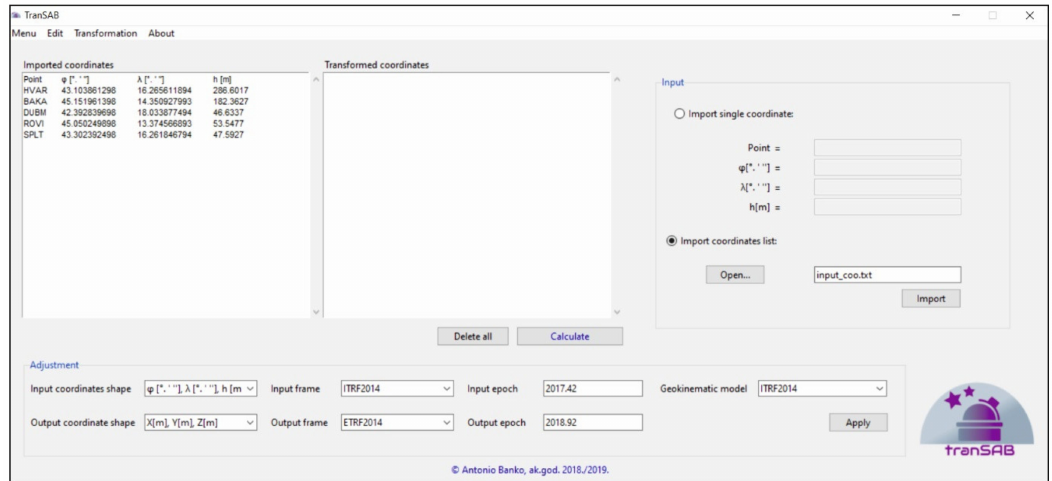
Figure 5. TranSAB application parameter adjustment and coordinate